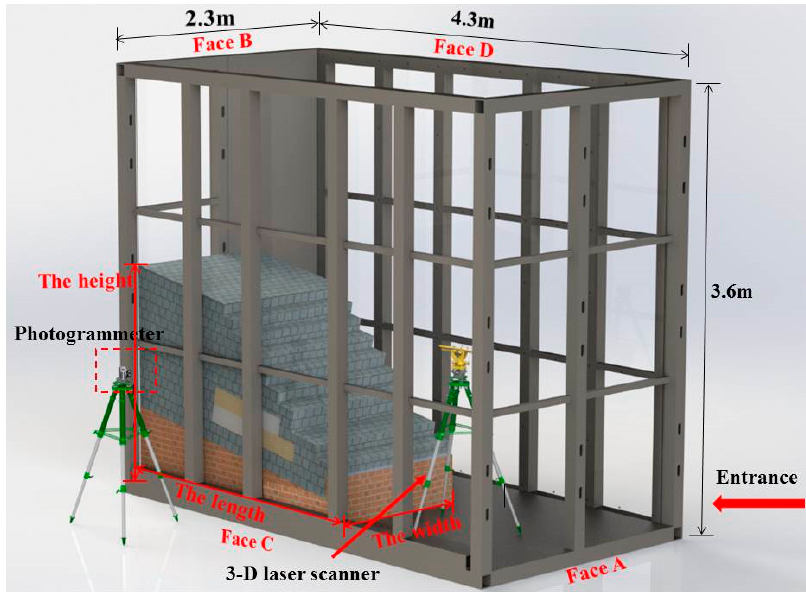
Figure 3. The model box and monitoring program.